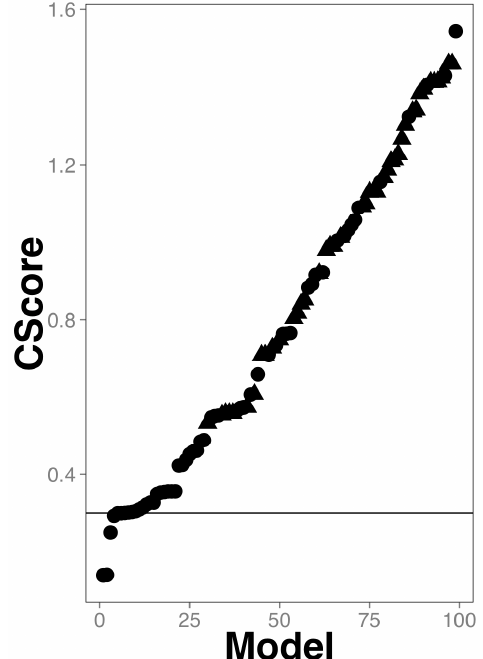
Figure 2. Classifiers combined scores. A circle represents each model; the best model has the lowest CScore . The line represents the CScore = 0.3, that separates the top 5 models from the rest. The models using heterologous data are represented as circles; triangles are used otherwise. The actual data of this plot can be found in Supplementary Table